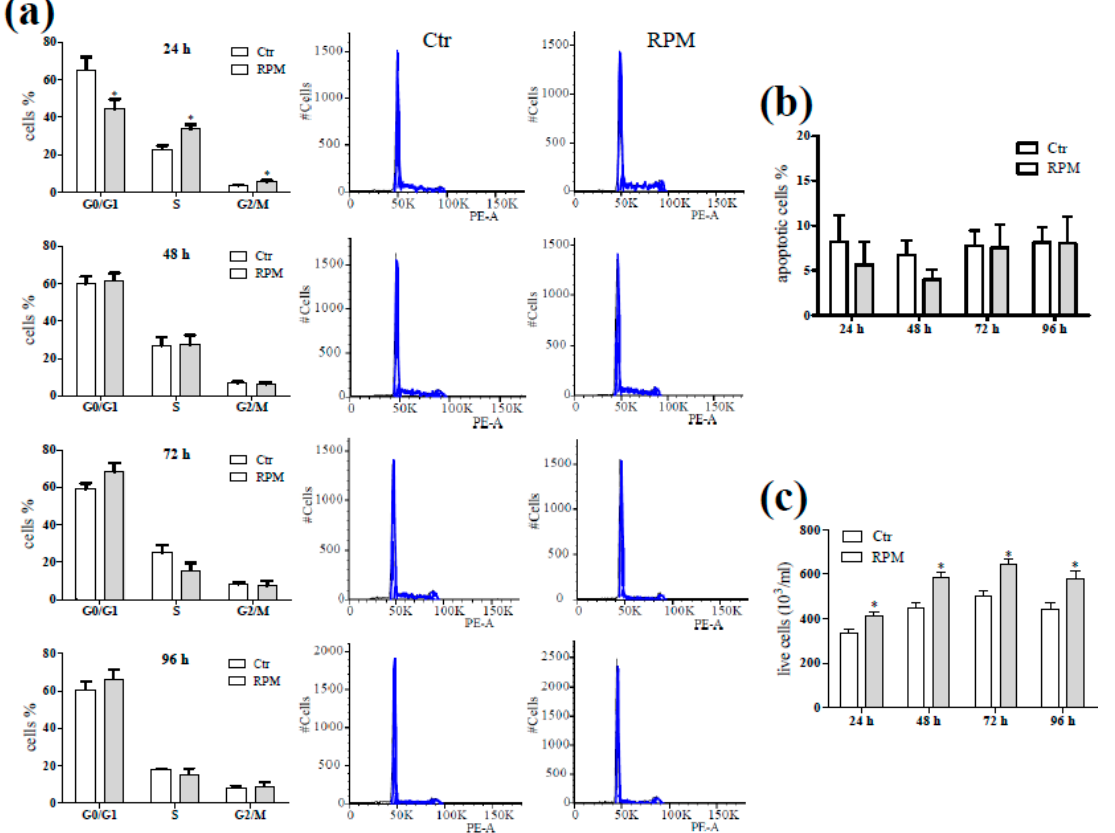
Figure 2. Cell cycle progression and proliferation. ( a ) The percentage of cells in different phases of the cell cycle after exposure under standard (at 1 g, Ctr) or s-microgravity (RPM) conditions, at 24, 48, 72 and 96 h of culturing. The graphs on the sides of the histograms are representative cell cycle profiles of Ctr and RPM cells cultured for 24–96 h. ( b ) Percentages of apoptotic cells derived from cytofluorimetric analysis of the hypodiploid populations. ( c ) Cell growth detected by the trypan exclusion assay on Ctr or RPM conditions. Values of the histograms are presented as means ± SEM, n = 3. * p < 0.05 compared with the corresponding Ctr.